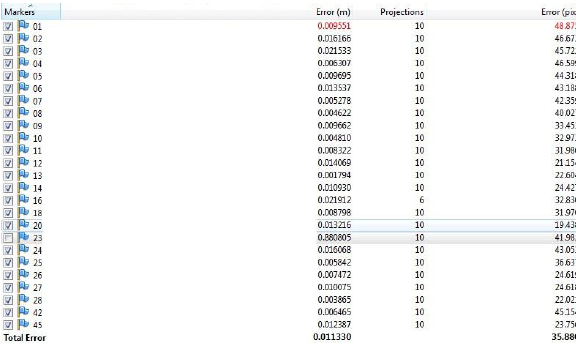
Table 8. Results of the bundle adjustment process for Intova camera A maximum error of 9.551 mm can be detected from the table whereas the average total error is 11.330 mm. In Table 9 and 10 results from the calibration procedure and bundle adjustment errors are reported for the © GoPro HERO 2.